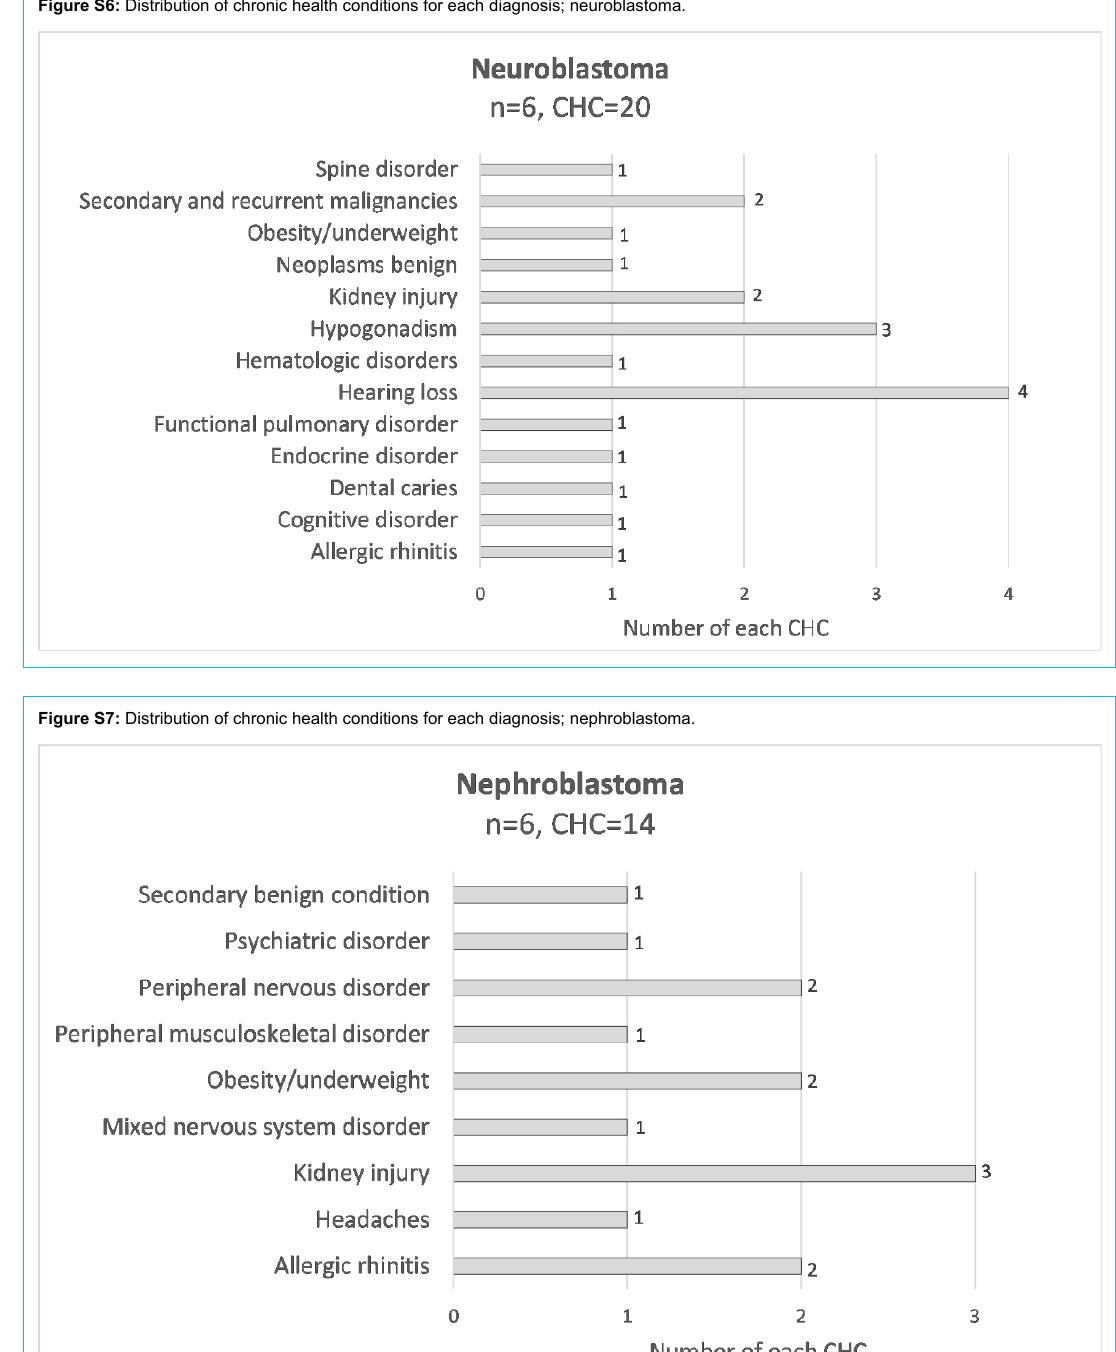
Figure S6: Distribution of chronic health conditions for each diagnosis; neuroblastoma.